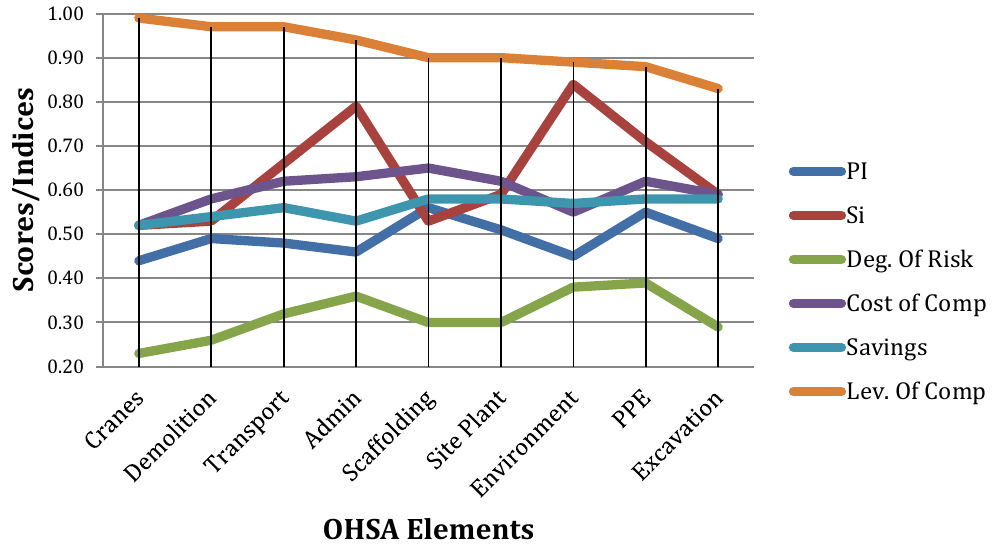
Figure 2 Breakdown of detailed scores/indices for variables used in the study